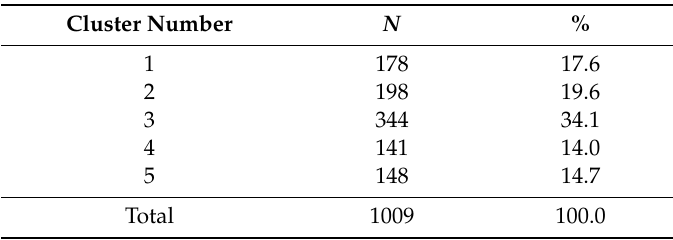
Table 3. Number of cases in each